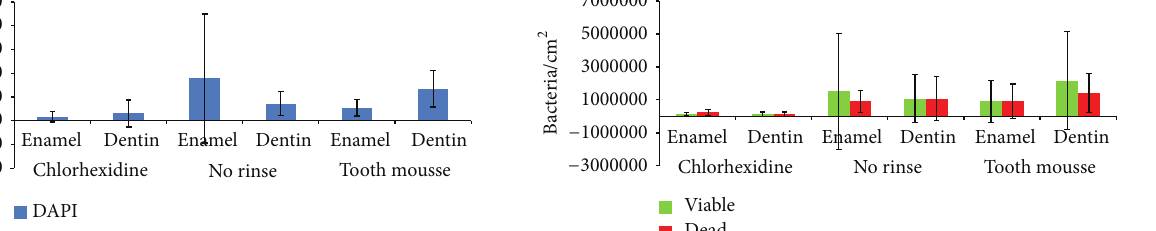
Figure 3: Live/dead staining (BacLight) for detection of viable and dead bacteria after application of GC Tooth mousse, rinses with chlorhexidine, or no rinse. Exposure of enamel and dentin samples for 8h overnight in situ . MV ± SD, 𝑛 = 8 subjects, two samples per subject and